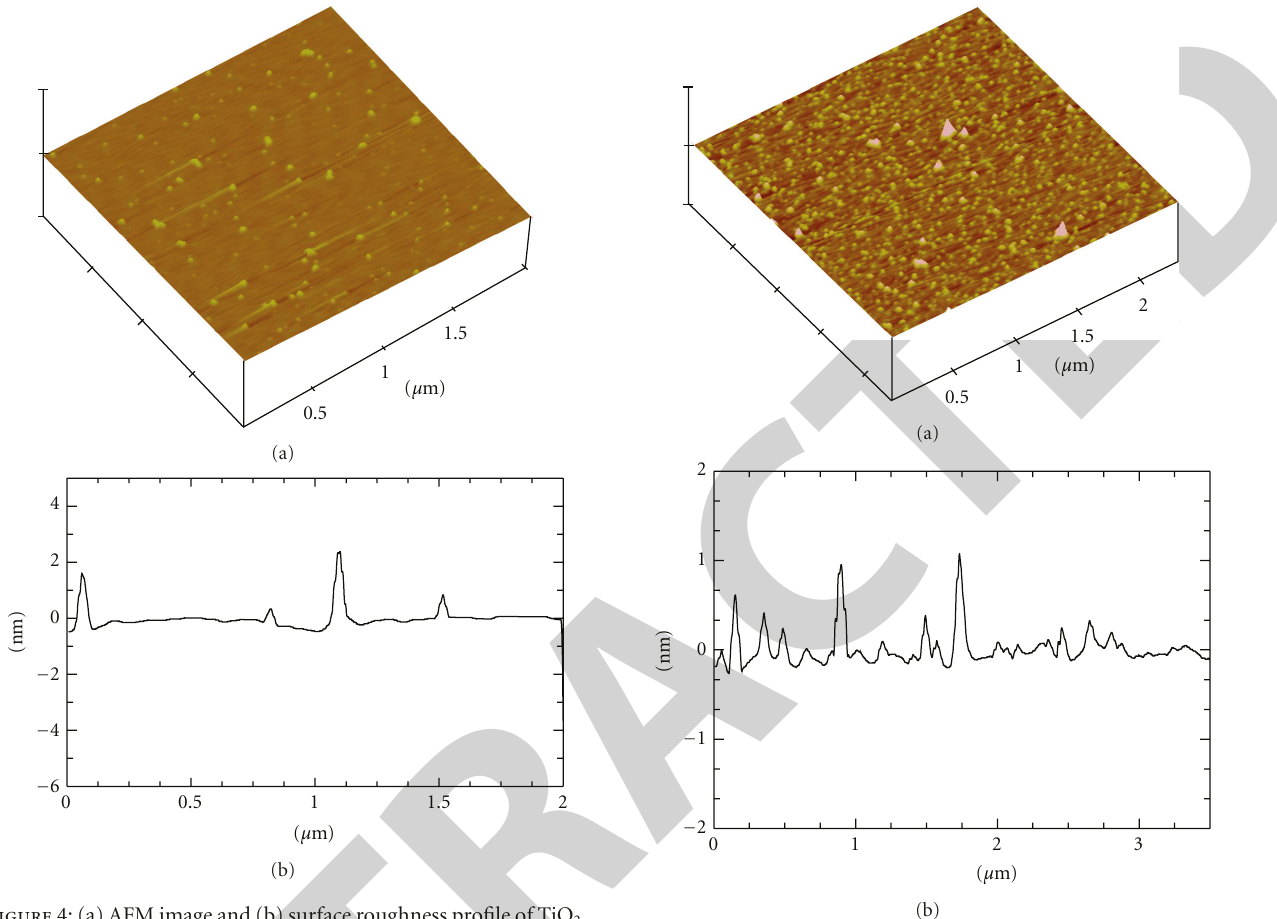
Figure 4: (a) AFM image and (b) surface roughness profile of TiO 2 .